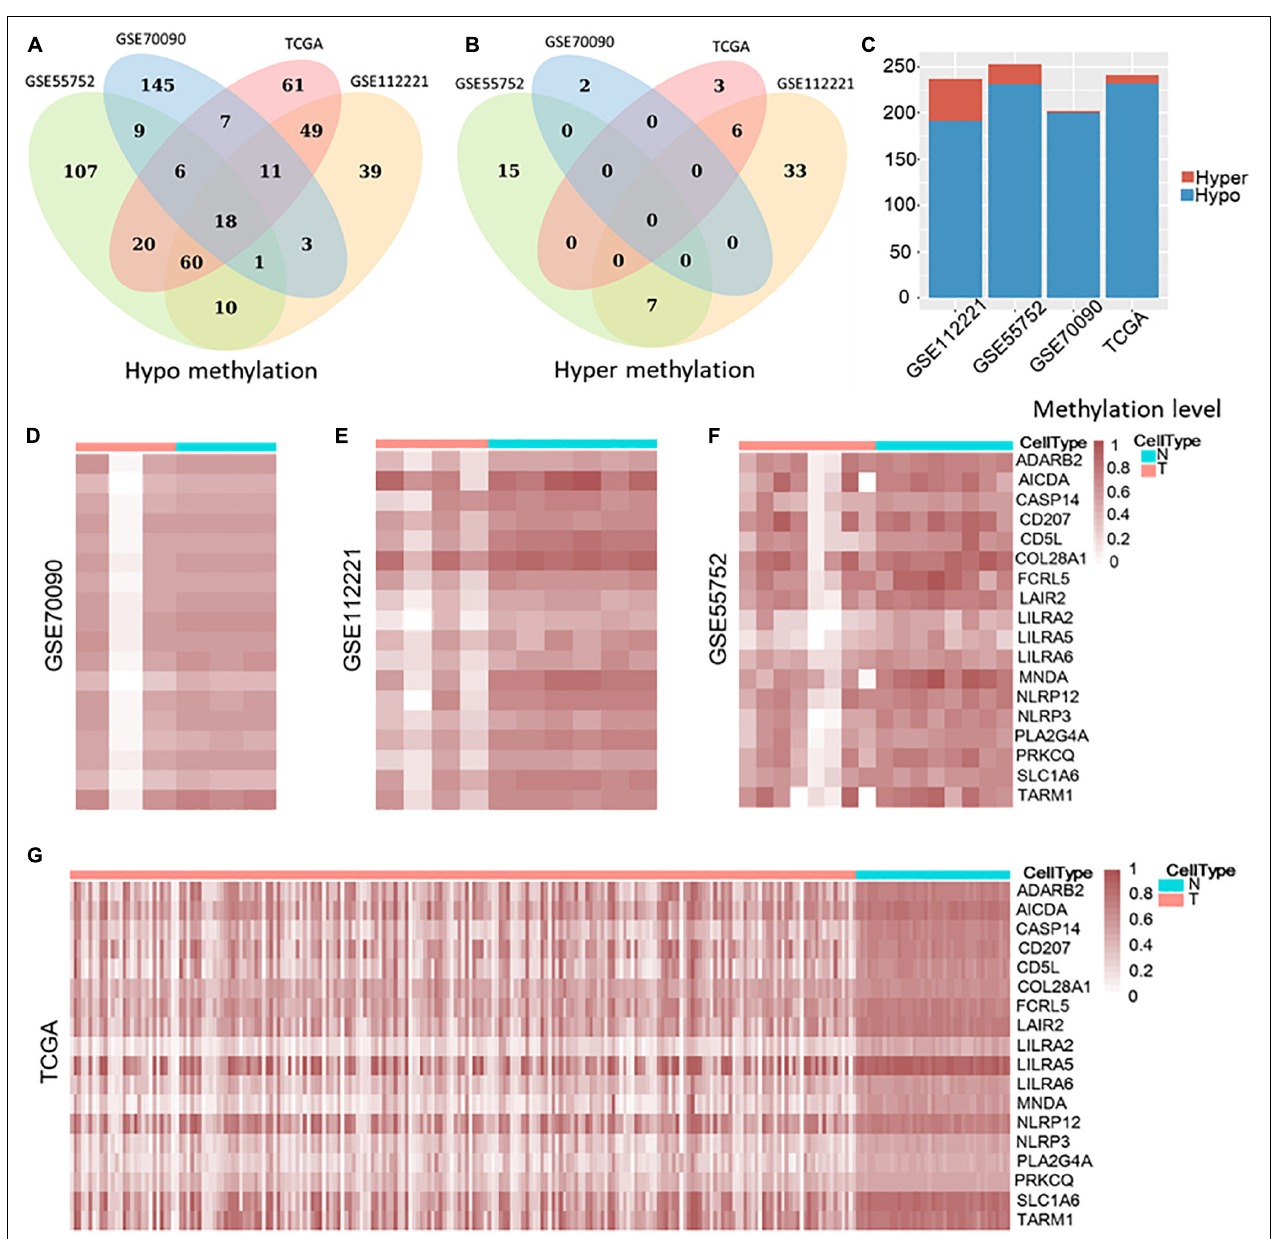
FIGURE 2 | Hypo and hyper methylated genes in GSE70090, GSE112221, GSE55752, and TCGA (A–C) . Heat map of 18 common hypo-methylated genes in four datasets (D–G)